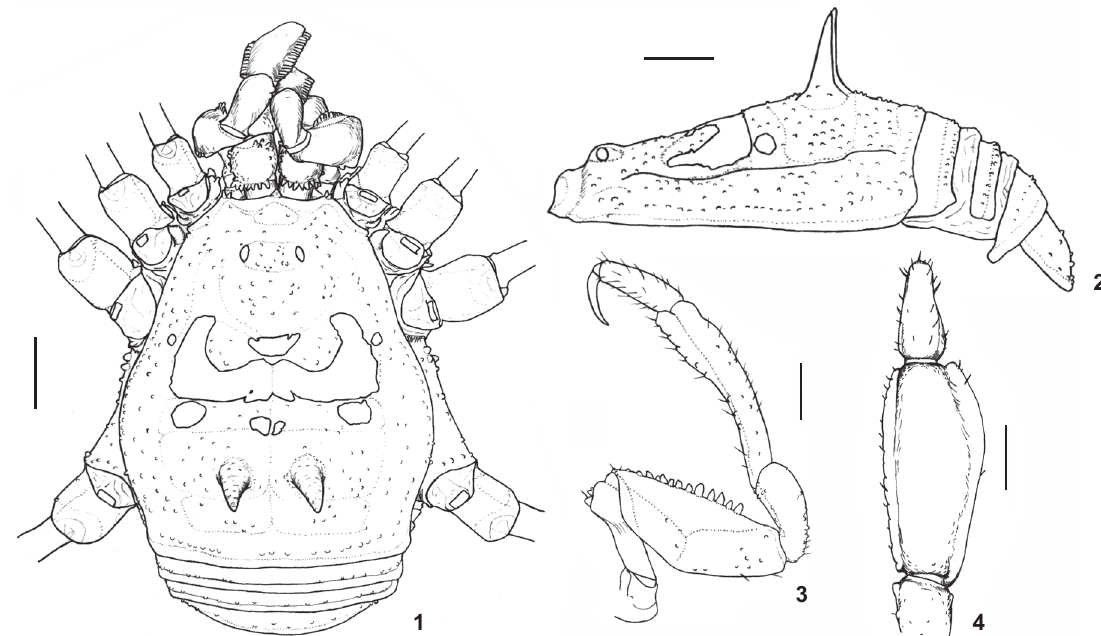
Figures 1-4. Holotype male of Paecilaema batman sp. nov. : (1) dorsal view; (2) lateral view; (3) pedipalp; (4) pedipalpal tibia and tarsus. Scale bars: 1-2 = 1 mm, 3-4 = 0.5 mm.